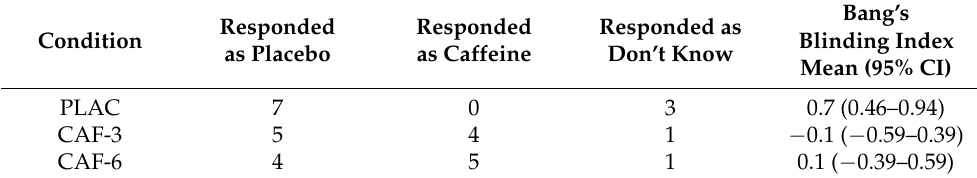
Table 4. Results of the assessment of